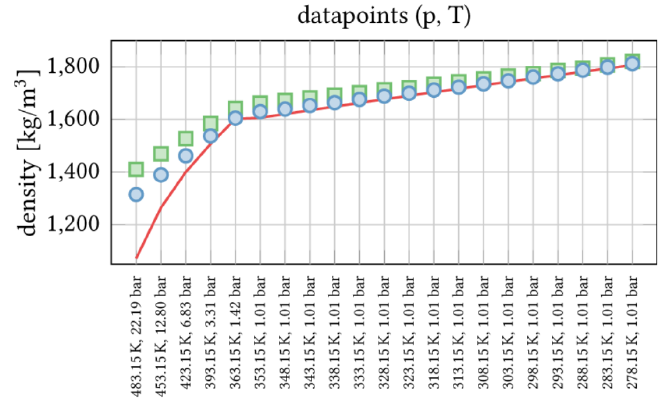
Figure 3. Computed densities for perfluorinated octane and different combinations of pressure and temperature. The optimized parameters found in this work ( • ) reproduce the experimental values (/) better than the original CGenFF parameters ( (cid:4)